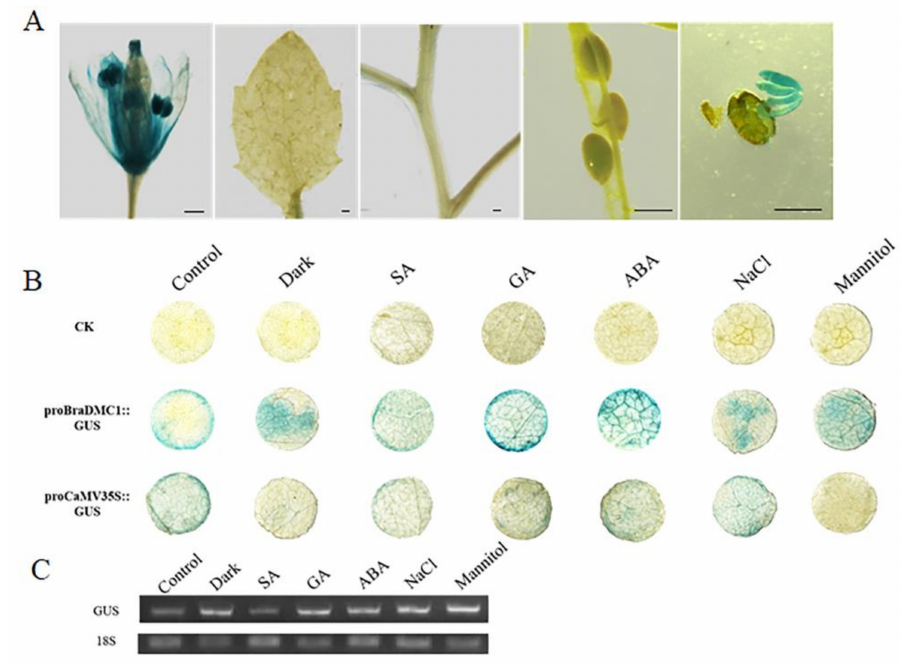
Figure 3. GUS staining analysis of the BrDMC1 promoter. ( A ) GUS staining analysis of BrDMC1 promoter in flowers, leaves, stems, pods and seeds of transgenic A. thaliana . Bar = 400 µ m. ( B ) GUS staining of Nicotiana benthamiana (N. benthamiana) leaves after different treatments. ( C ) The expression of GUS was determined by semi-quantitative PCR.